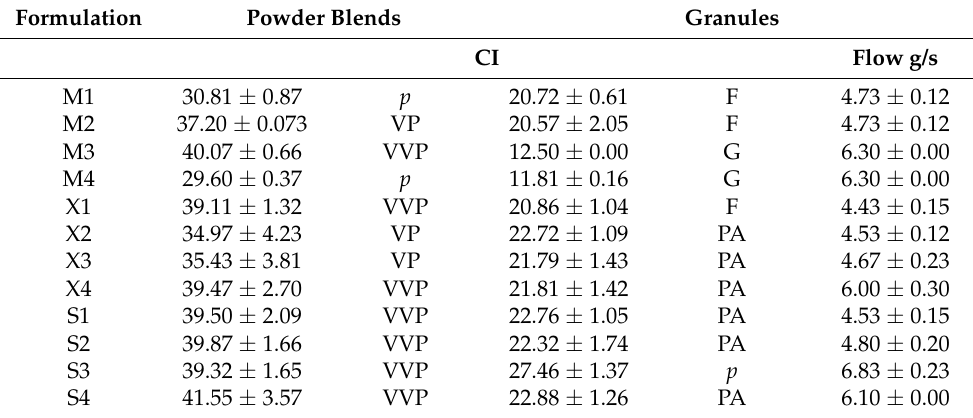
Table 2. Flow rate (g/sec) of granules through a 10 mm orifice size. Data are expressed as mean ± SD, n =